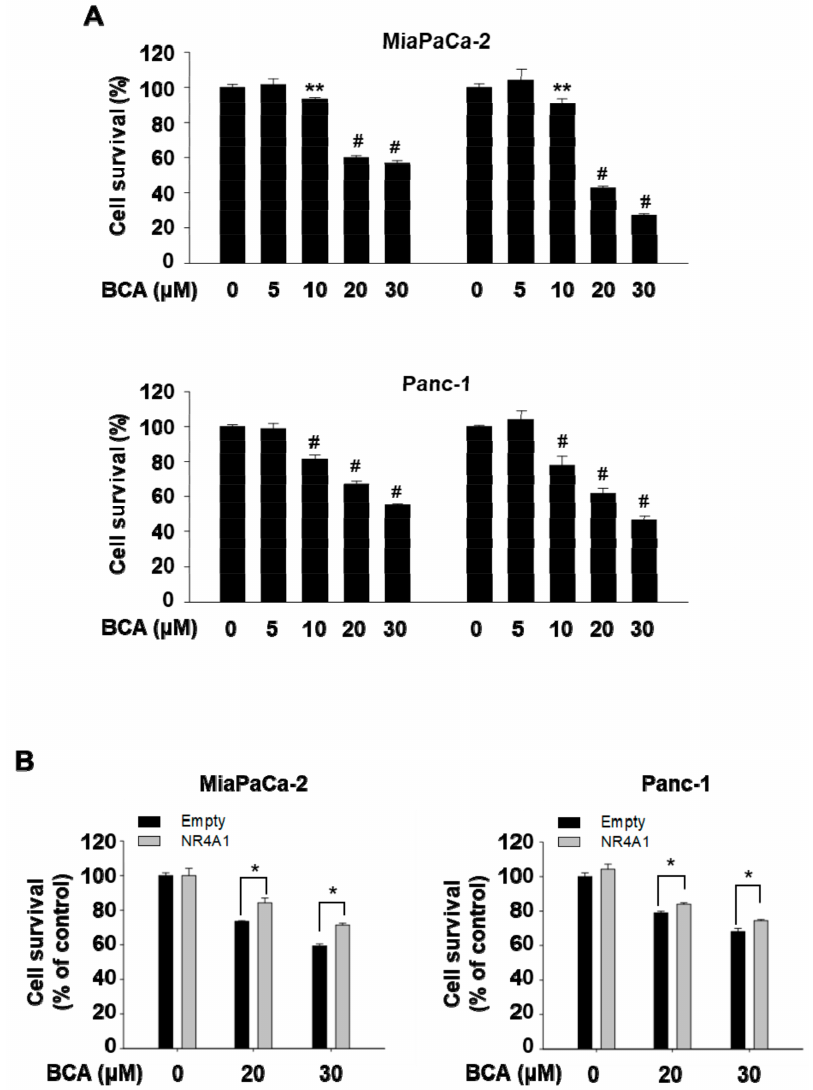
Figure 3. BCA inhibits cell proliferation in pancreatic cancer cells. ( A ) Cells were treated with various concentrations of BCA for indicated time, and cell viability was determined as described in the Section 3. ( B ) Cells were transfected with either Flag-empty or Flag-NR4A1 for 6 h, and at 24 h after transfection, cells were treated with BCA for 24 h. The results are presented as means ± SEM. * p < 0.05, ** p < 0.01, and # p < 0.001 vs.